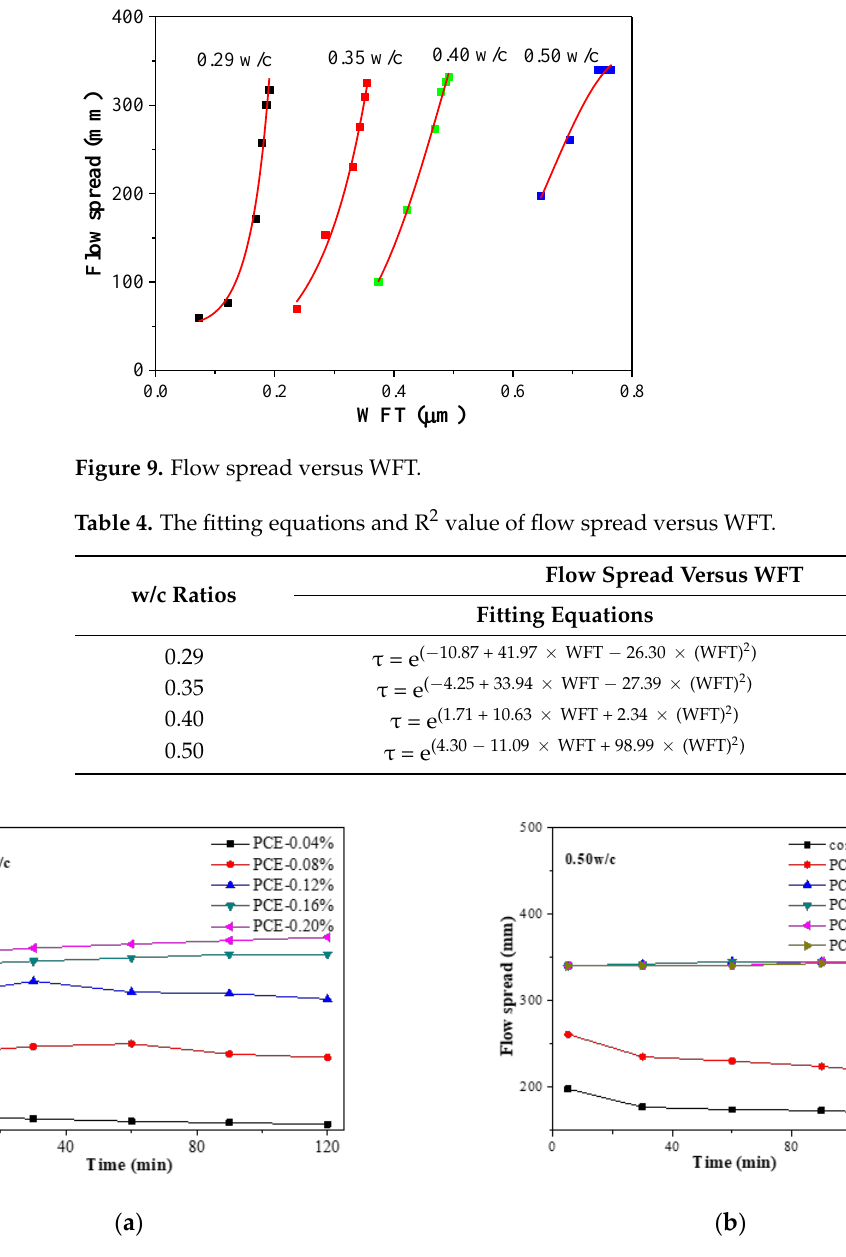
Figure 10. Influences of PCEs on the fluidity retention of cement pastes at two w/c ratios: ( a ) w/c = 0.29 and ( b ) w/c = 0.50.